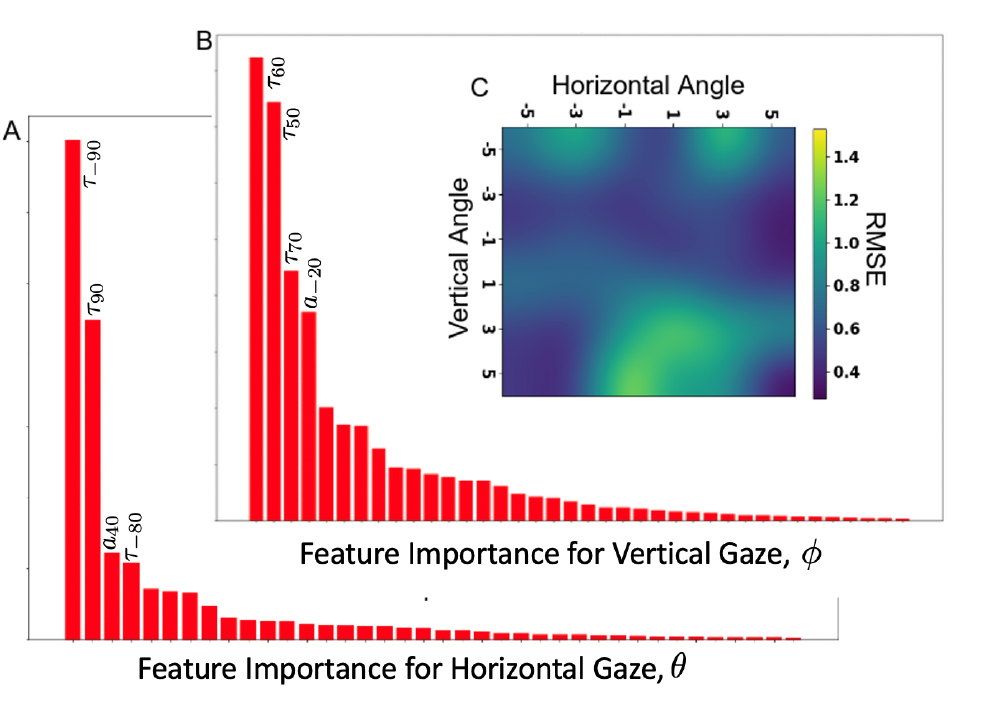
Figure 11. Feature importance and mean accuracy of GBRT models to estimate gaze. ( A ). Horizontal gaze, ( B ). Vertical gaze, ( C ). Error as a function of gaze